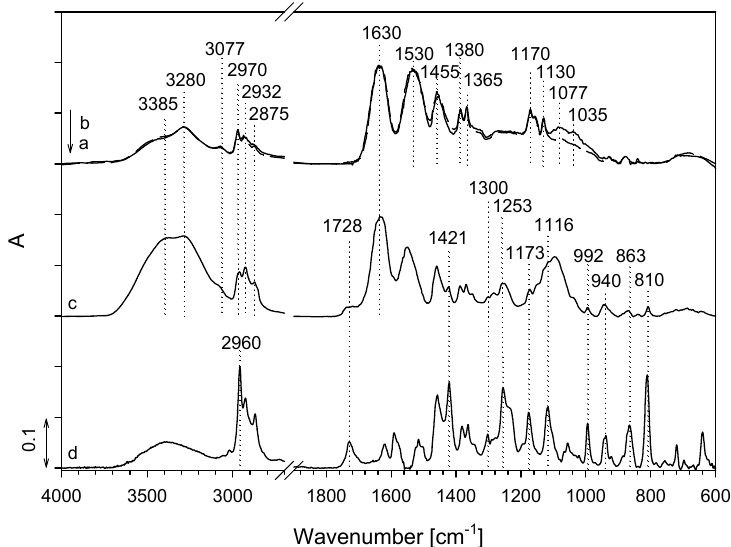
Figure 6. Infrared attenuated total reflection (IR ATR) spectra of the pure PNCS M1 hydrogel ( a ), PNCS/CD M1 hydrogel before ( b ) and after in situ functionalization by water emulsion of savory essential oil (EO) ( c ) and of pure savory EO ( d ) deposit on a Si wafer.